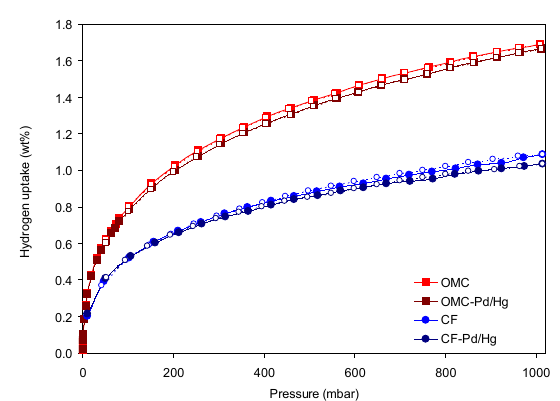
Figure 3. H sorption-desorption isotherms at 77 K (desorption: 2 open symbols.).